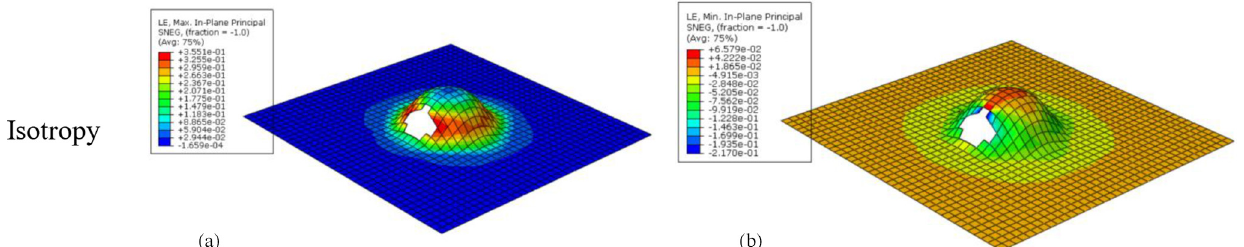
Fig. 15. (a) Maximum in-plane principle strain under biaxial stretching. (b) Minimum in-plane principle strain under biaxial